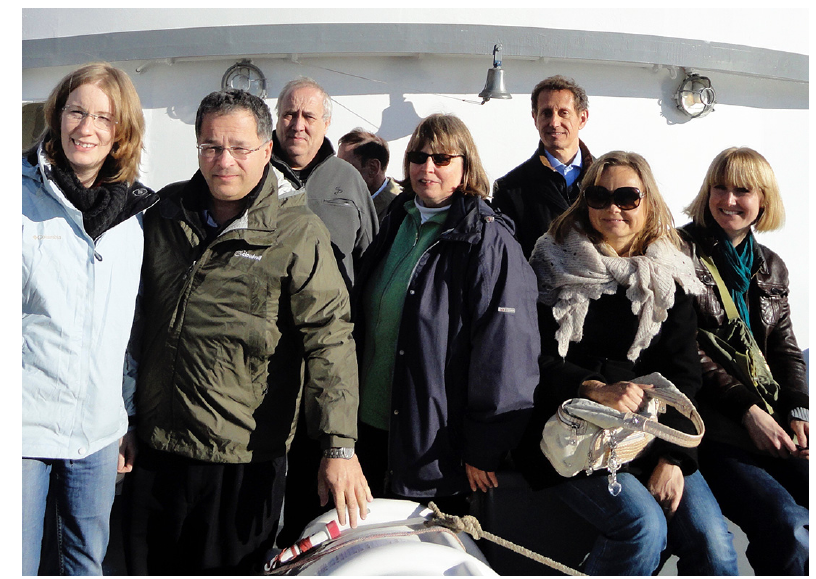
Figure 3: Boat trip on May 5, 2010, as part of the Third Annual Conference on Extreme Events and Related Issues held in Sta- vanger, Norway. From left to right: Johanna Nešlehová, Christian Genest, Christian Gouriéroux, Claudia Czado, Tom Arild Fearn- ley, Kjersti Aas, and Ingrid Hobæk